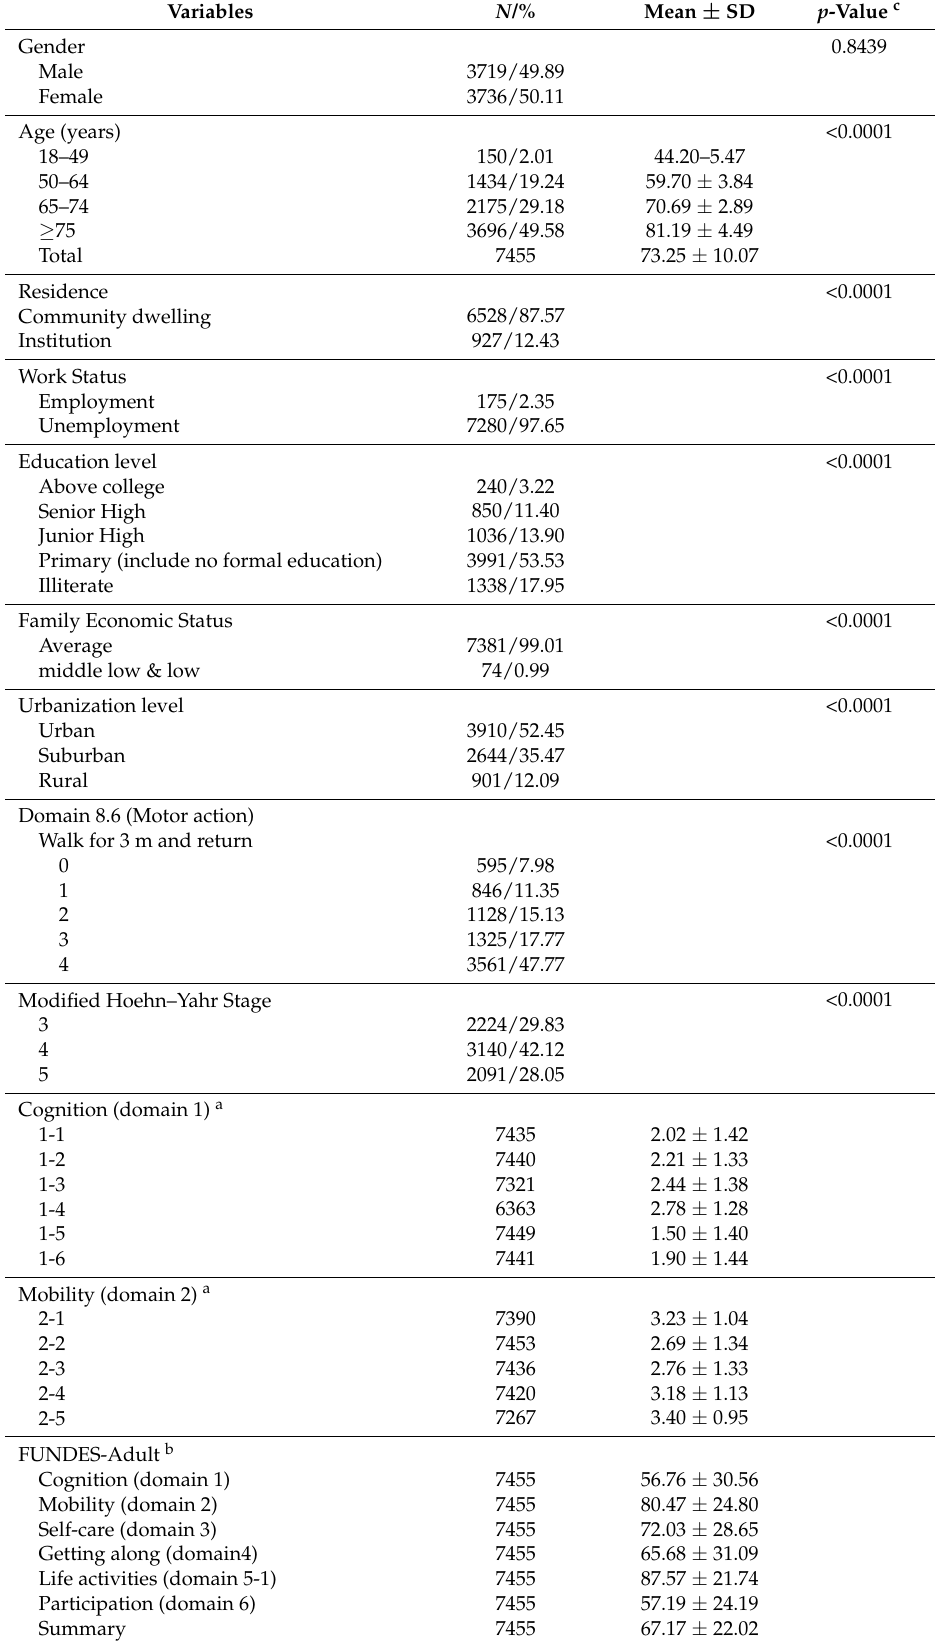
Table 1. Demographic table, n =